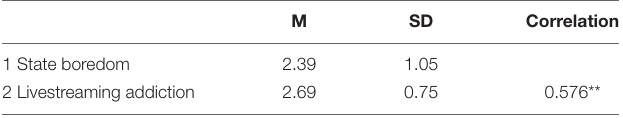
TABLE 2 | Means, standard deviations (SDs), and correlations of variables in Study 1. M SD Correlation